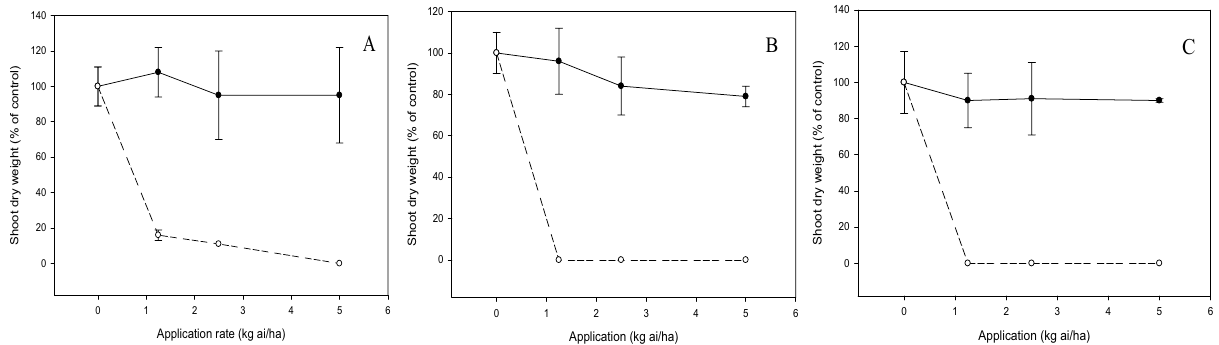
Figure 9. Phytotoxic effects of c (solid line) and diuron (dashed line) treatment on shoot dry weight of Brassica rapa ( A ), Oryza sativa ( B ) and Zea mays ( C ) 2 weeks after pre-emergence application.